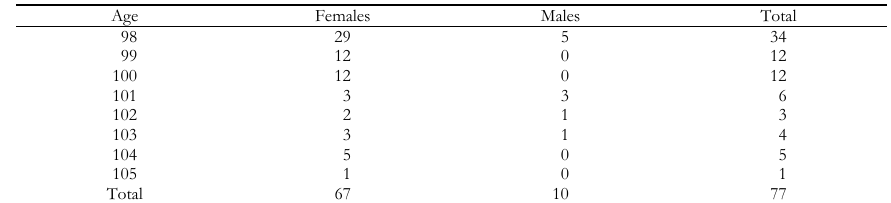
Age and gender distribution of the participants in the MALVA study Age